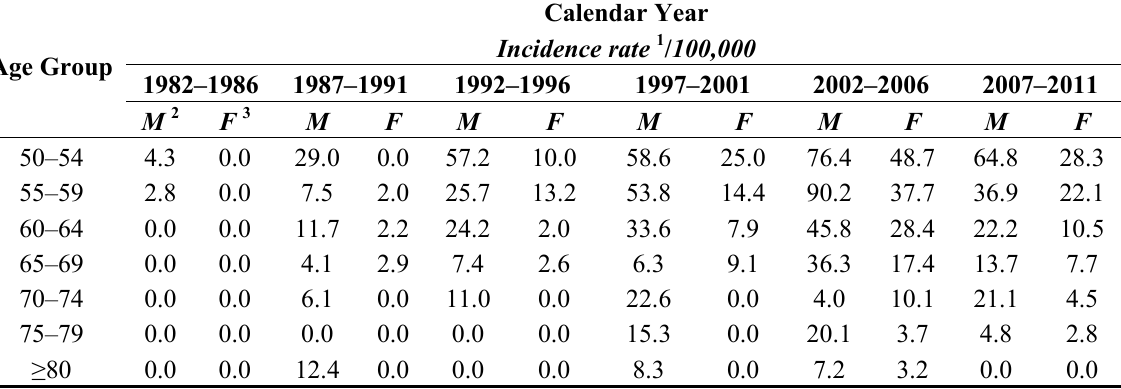
Table 1. Descriptive analysis of time series data of the incidence of AIDS (1982–2011) by